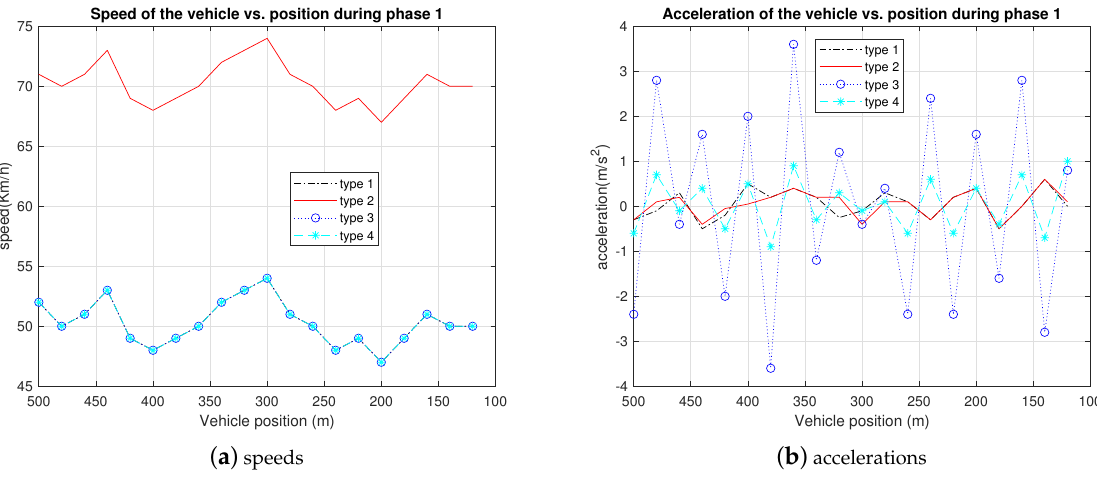
Figure 3. Selected driver examples: type 1 (dash-dot), type 2 (solid), type 3 (dot), type 4 (dash). Speeds ( a ) and accelerations ( b ).